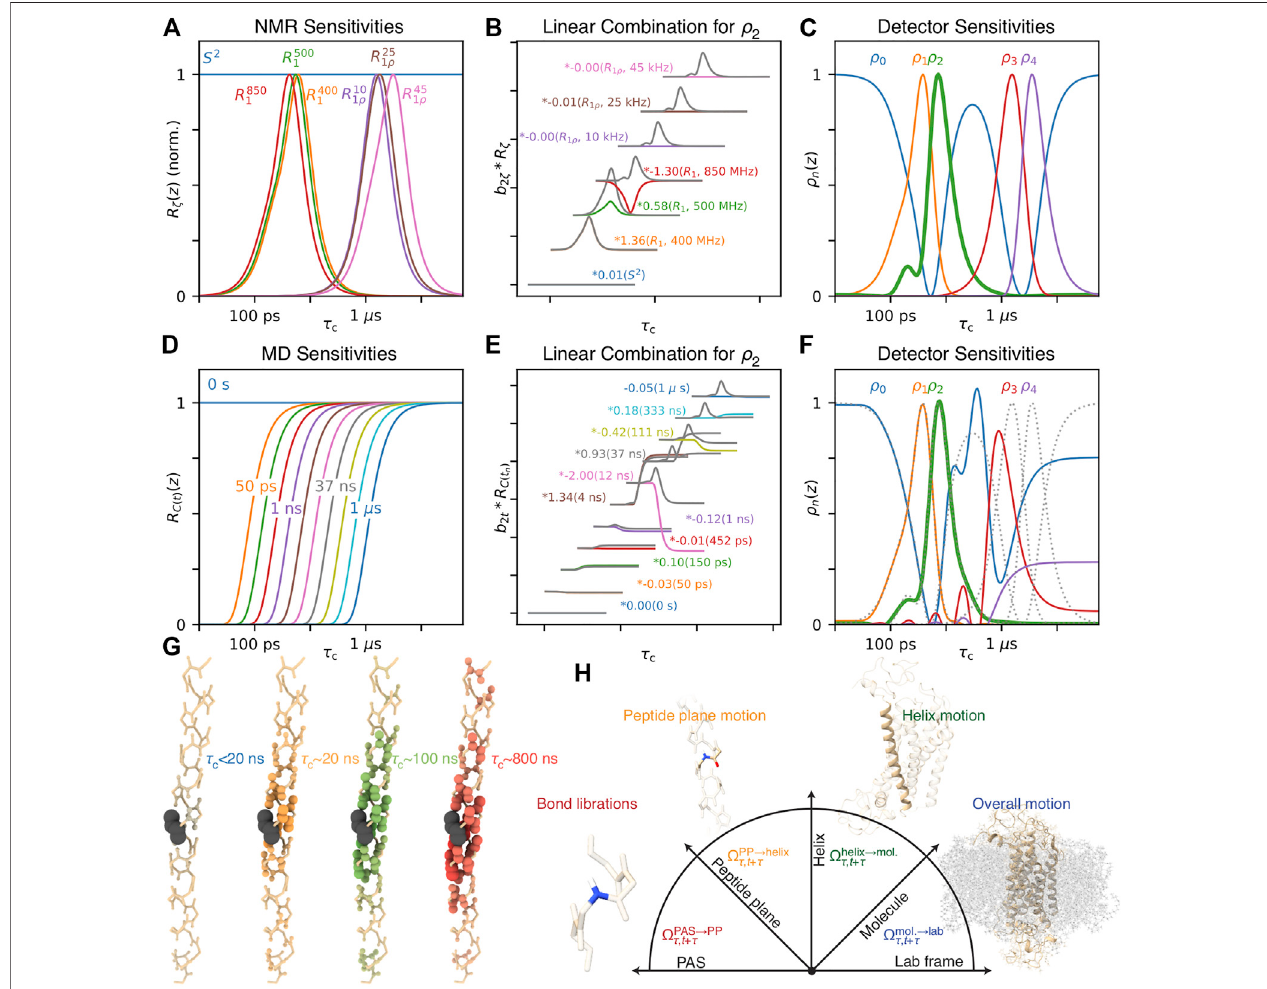
FIGURE14| CombiningNMRandMD. (A) plotsnormalizedNMRsensitivitiesforaselectionofexperiments( S 2 , 15 N R 1 at400,500,850 MHz, 15 N R 1 ρ at850 MHz, 60 kHz MAS, ] 1 at 10, 25, and 45 kHz). (B) shows a linear combination of the normalized sensitivities ( x , y positions shifted to reduce plot overlap), which yields the sensitivityof ρ 2 ,shownin (C) (green,bold).Incoloraretheweightedcontributionsfromeach rateconstant,and greyshowsthecumulativesum(summingallsensitivities atandbelowthegreyline). (C) showsthe fi vesensitivitiesoptimizedfromNMRdata. (D) plotssensitivitiesoftimepointsfromMD-derivedcorrelationfunctions(0 s, 10pointslog-spacedfrom50 psto1 μ s). (E) showsalinearcombinationofthosesensitivities,optimizedtomatchthesensitivityof ρ 2 ( x,y positionsshiftedtoreduceplot overlap). (F) shows detectors optimized to match the NMR-derived detectors in (C) . (G) shows spatial correlation of motion in a helix as a function of correlation time (windowsfor < 20, ∼ 20, ∼ 100, ∼ 800 ns).Colorintensityandbondradiiindicate thecorrelationcoef fi cientbetweenthatresidue ’ sH – Nmotionandthemotionoftheblack residue. (H) illustrates frames used to separate transformation from the PAS to the lab frame into four steps: a peptide plane frame, a helix frame, and a molecule frame (illustration inspired by Brown (1996), molecule plots created with ChimeraX (Pettersen et al., 2021)).